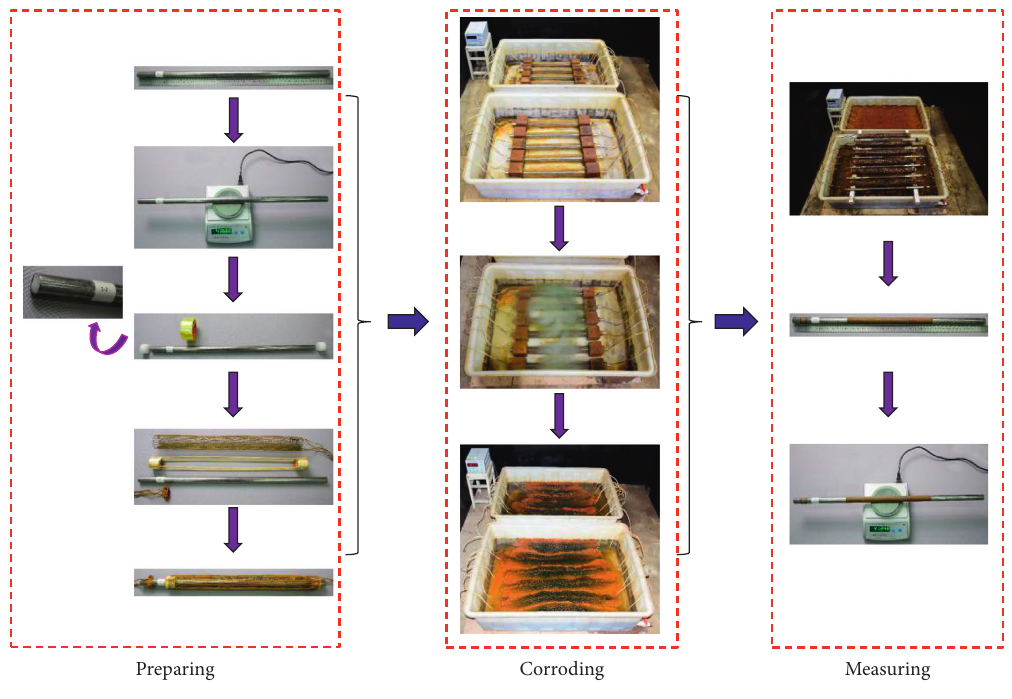
Figure 5: Process of electrochemical corroding process.